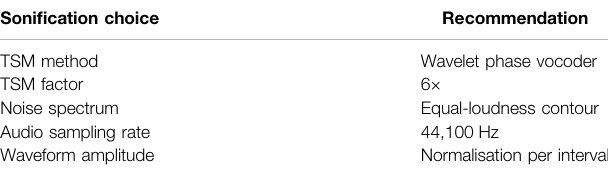
TABLE 2 | Final recommendations on ULF wave soni fi